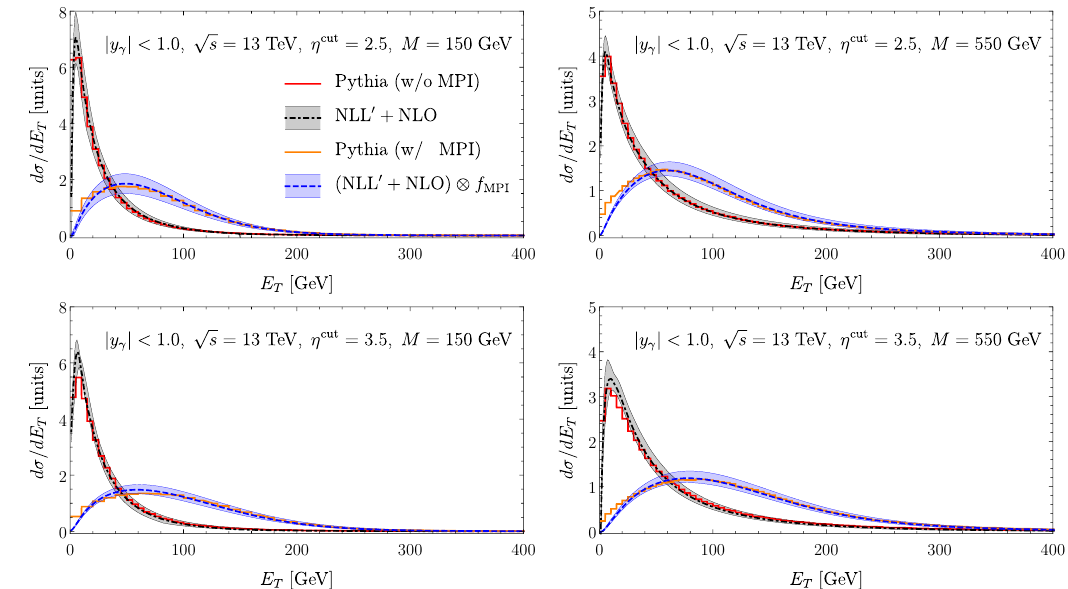
Figure 2 . The NLL-prime resumed distributions evaluated from eq. (2.35) and convolved with the half Gaussian model function (blue dashed) and the Pythia simulations (ISR+MPI) (orange solid). We also included the purely perturbative result (black dot-dashed) compared against the result from Pythia partonic distributions (MPI-only) (red solid). In each plot all curves are arbitrarily normalized to the same